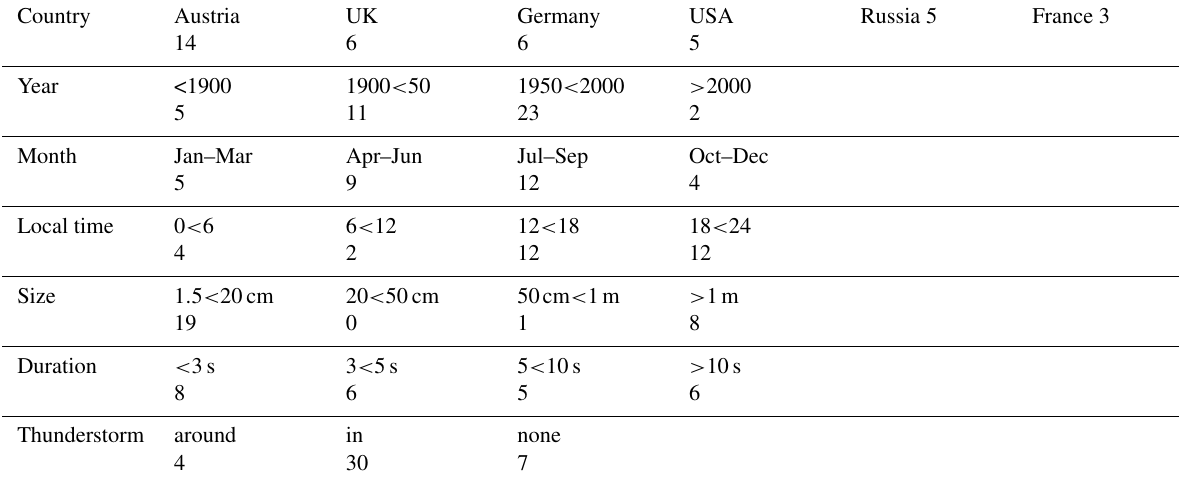
Table 1. Absolute values for reported country, year, month, local time of observation, object size, observation duration, and thunderstorm link of